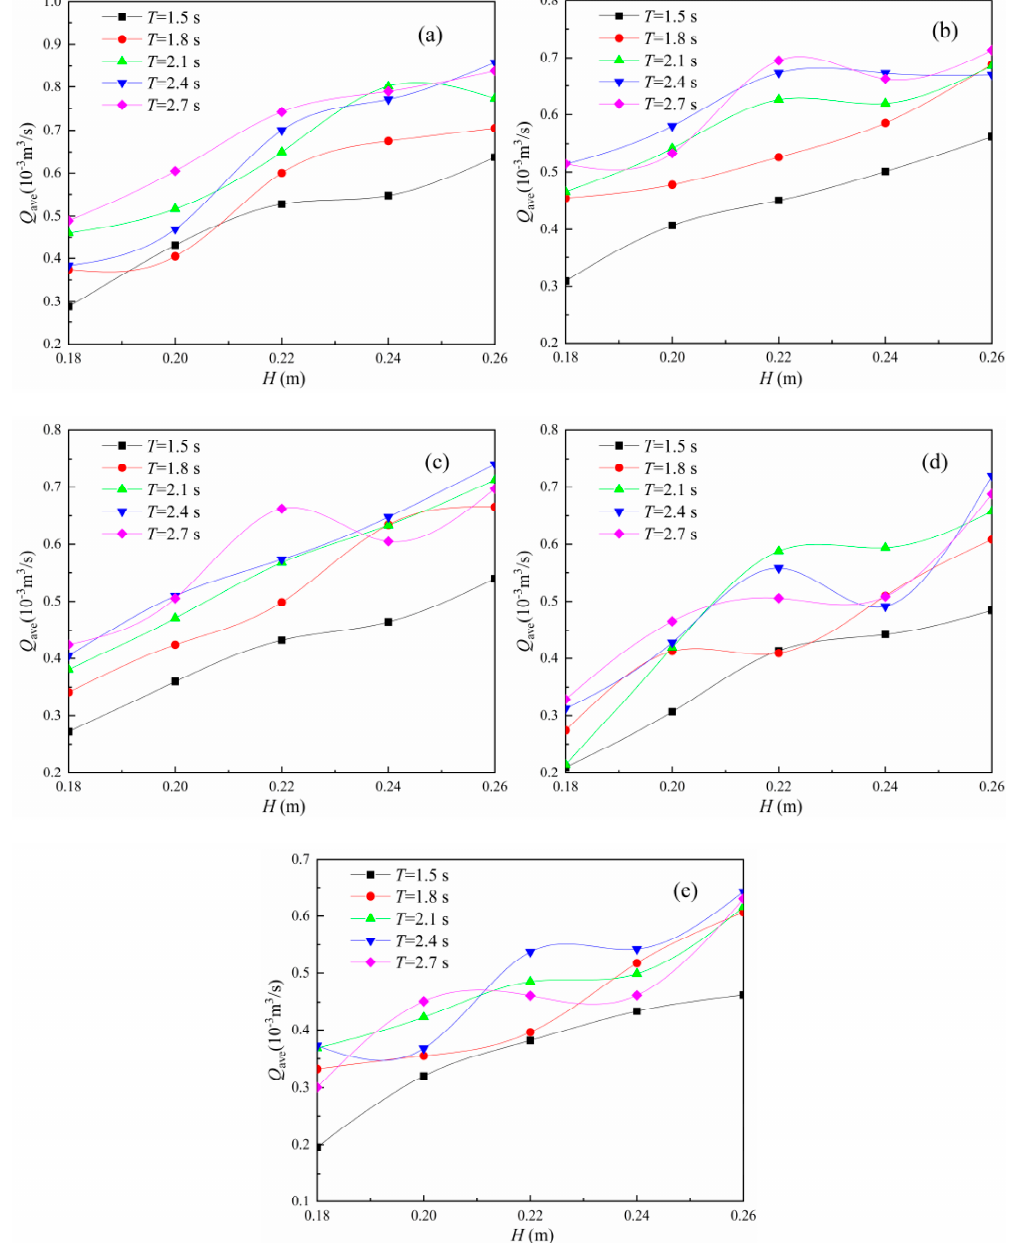
Figure 4. Q ave relationship with H . ( a ) h = 0.1 m; ( b ) h = 0.2 m; ( c ) h = 0.3 m; ( d ) h = 0.4 m; ( e ) h = 0.5 m.